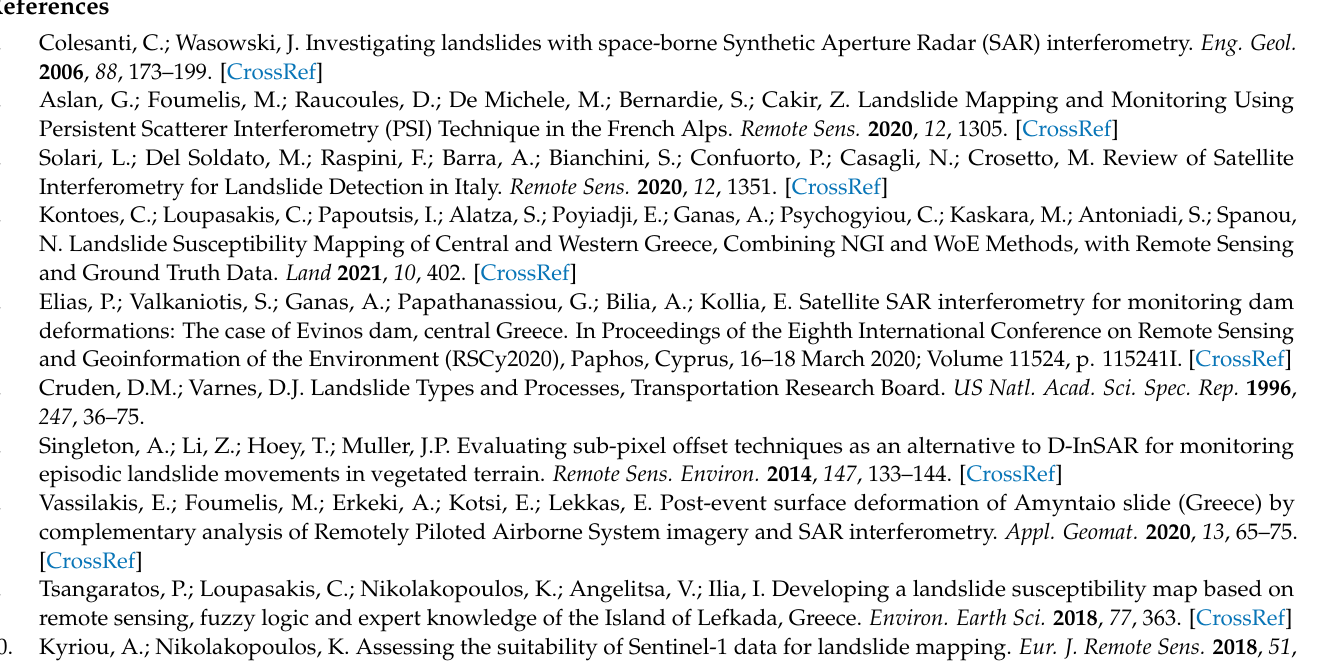
cross-correlation results. The corresponding displacement rates are reported in Table 2. Table S1. Dataset of Sentinel-1 SAR acquisitions of ascending and descending orbit used in this